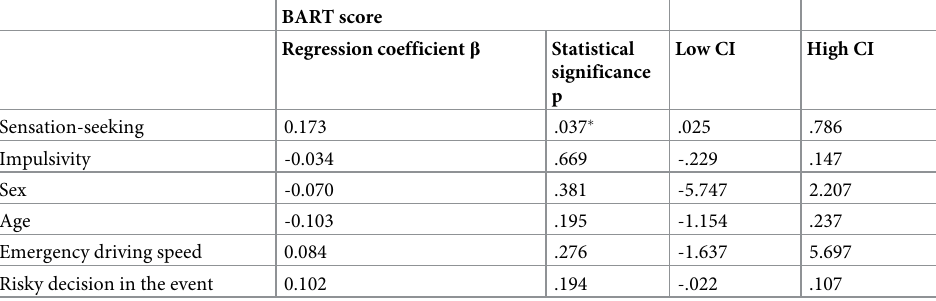
Table 3. Regression analysis for predicting BART scores from psychological